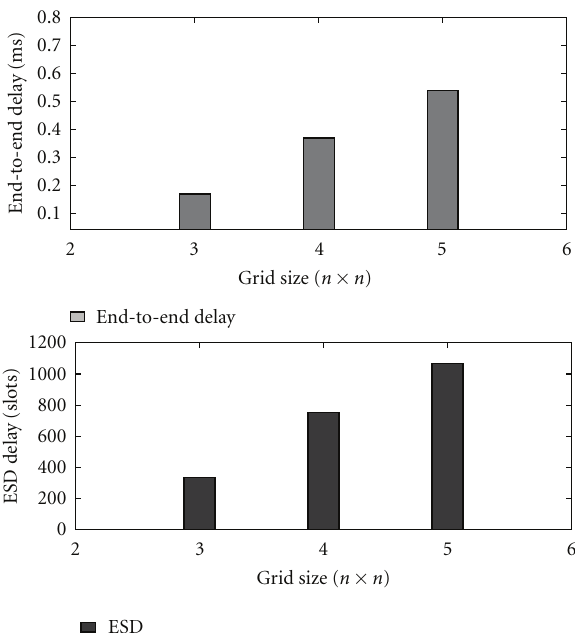
Figure 1: Expected scheduler delay versus end-to-end delay.